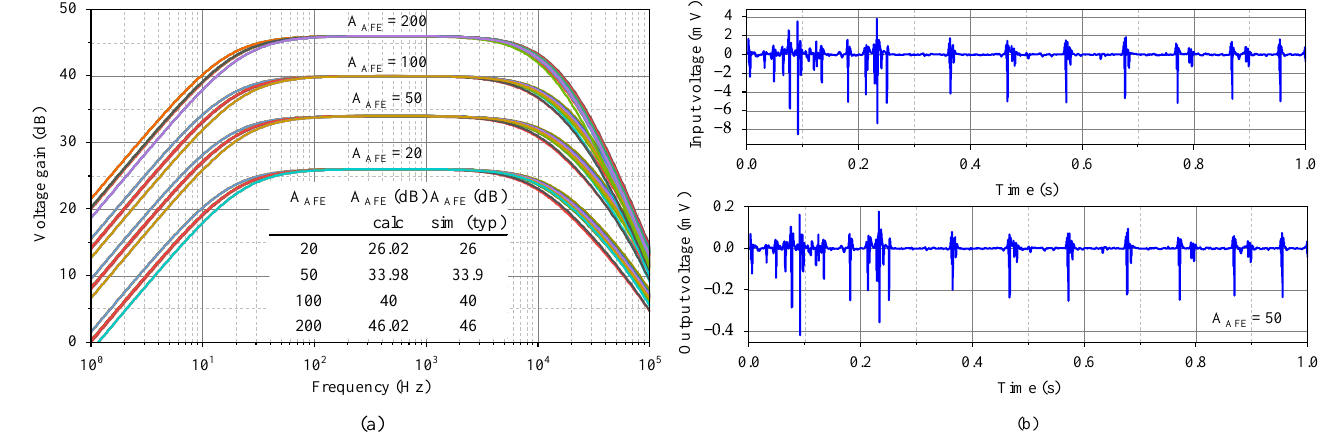
Figure 15. Variation in ( a ) frequency response at four different gain settings and ( b ) processing of the EMG signal.